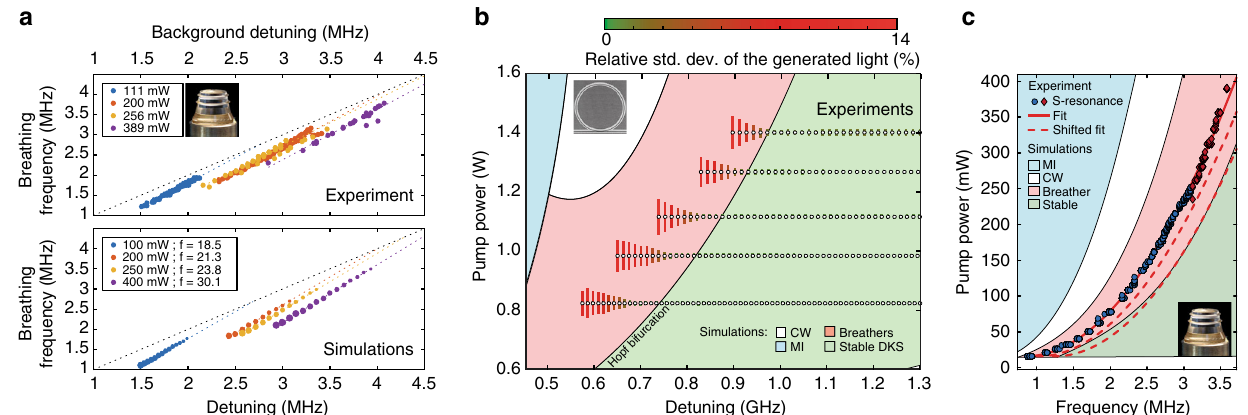
Fig. 4 Breathing dynamics and dependence on the parameters of the system. a Top : Experimental determination of the breathing frequency evolution with the detuning for different pump powers, retrieved by the modulation response measurement. Bottom : Simulated evolution of the breathing frequency (see Methods section for details). b Stability chart of the CW-pumped Si 3 N 4 microresonator in pump power over effective detuning coordinates. White fi lled circles indicate experimentally accessed DKS states. The colour-coded vertical lines indicate the measured relative standard deviation of the generated light power. The coloured background regions and boundaries are interpolated from simulation results (see Methods section for details) and correspond to: CW-state ( white ) — the soliton decays to the homogeneous background, chaotic modulation instability ( blue ), stationary DKS state ( green ) and breathing DKS state ( red ). c Dependence of the S -resonance on the pump power, measured for a stationary soliton. This resonance provides an estimate of the detuning point at which the breathing starts. The measurements were carried with the detuning stabilised to δ = 3.5 MHz for P < 300 mW ( blue dots ) and δ = 7 MHz P > 300 mW ( red marks ). The evolution fi ts to a parabolic dependence. The regions were retrieved with a polynomial fi tting of the boundaries from a simulated stability chart (see Methods section for details). The Hopf boundary obtained from the simulations is contained within a [+1, +2] κ /2 π margin ( dashed lines ) to the measured S -frequency, which is in agreement with the experimental observations reported in Fig.